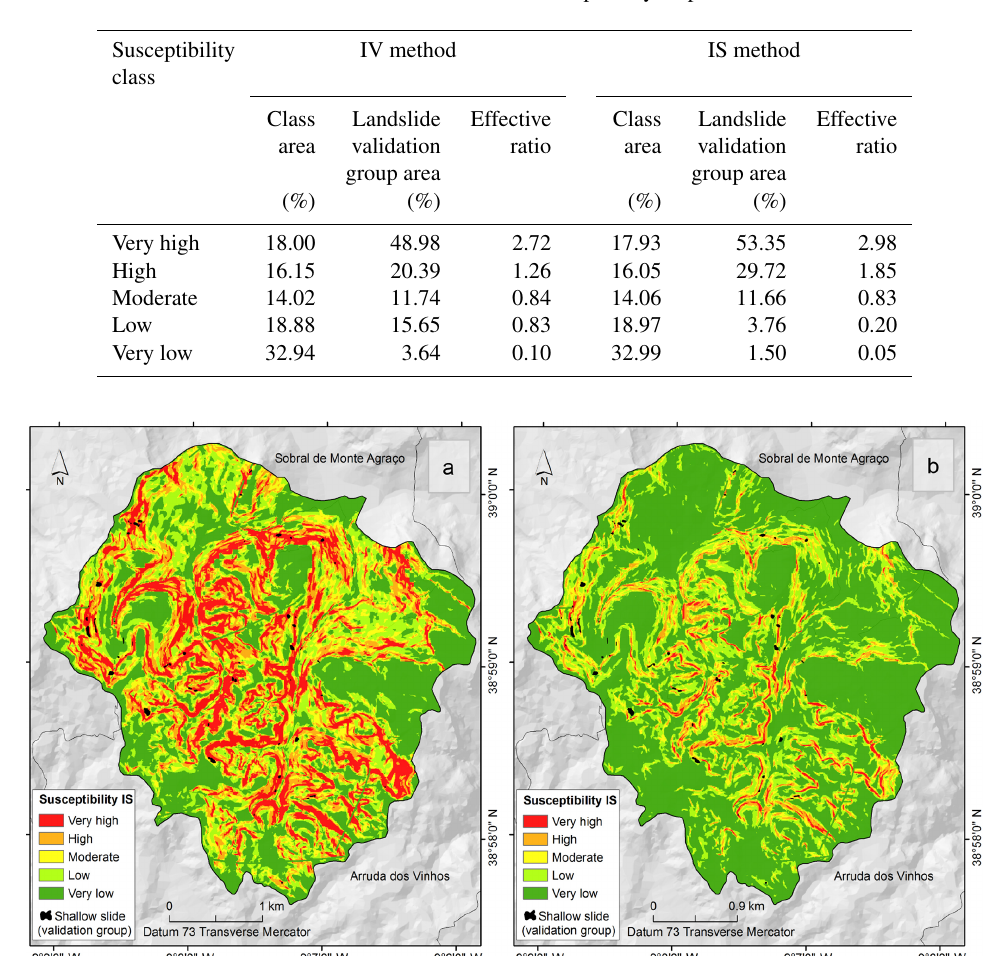
Figure 8. IS shallow slide susceptibility maps (a) m according to Fig. 5b; (b) m =